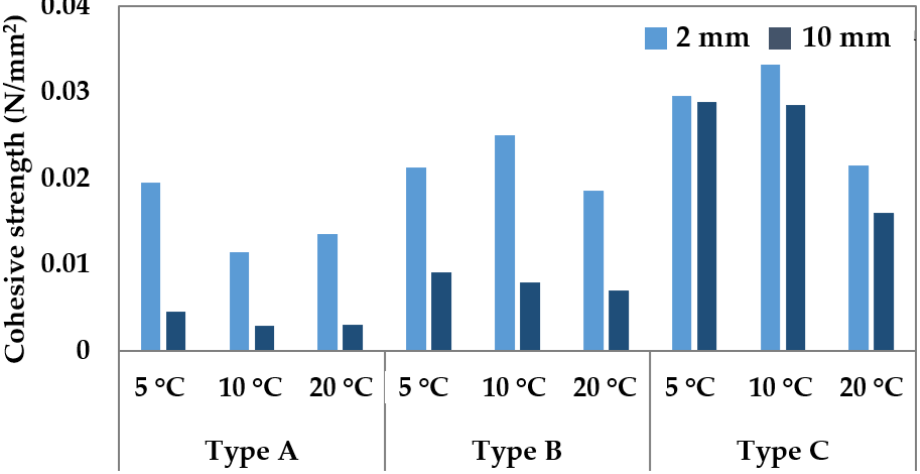
Figure 10. Cohesive strength comparison with sample thickness and